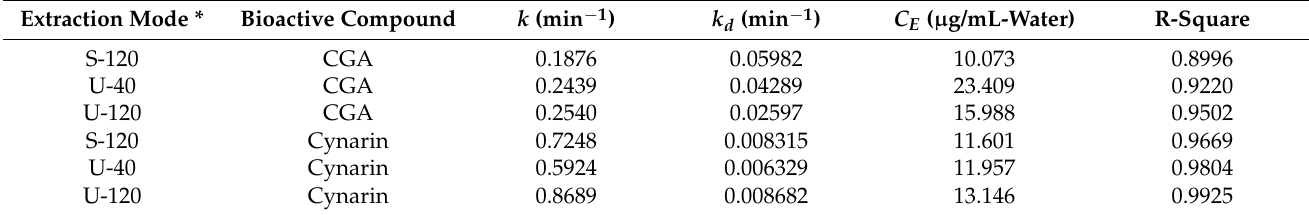
Table 3. Correlated values of k , k d , and C E using the kinetic model of extraction followed by degrada- tion for the extraction of chlorogenic acid (CGA) and cynarin from dried burdock root powder. Extraction Mode